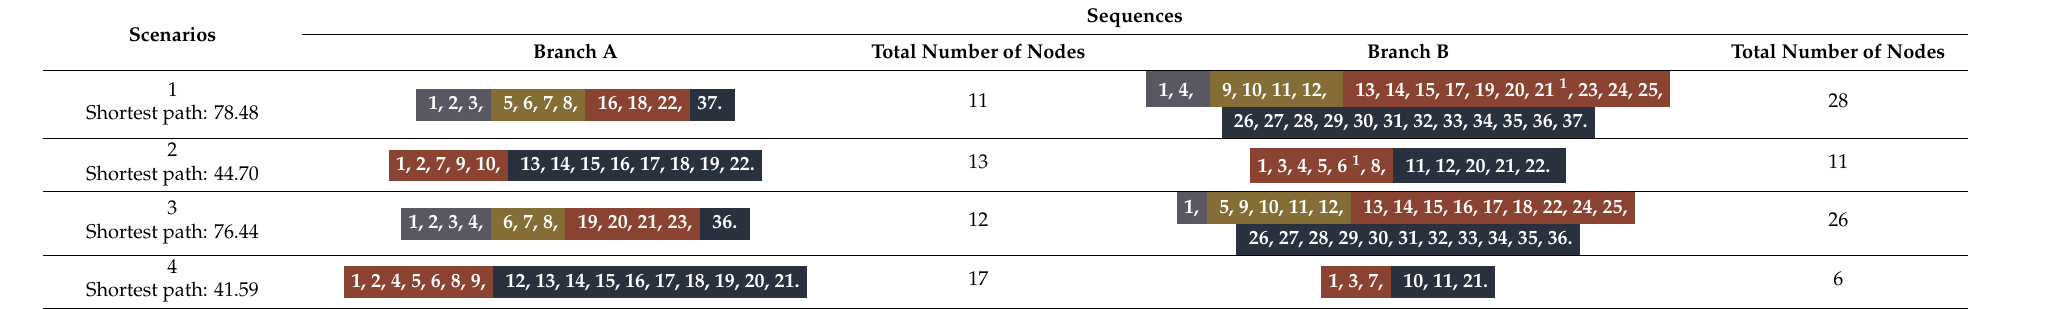
Table 5. Summary of the main results obtained from the application of the scheduling task optimization method to several established scenarios. (Legend: (cid:4) Operations from the reception of the grapes to the beginning of fermentation; (cid:4) Operations related to fermentation control, must be preparation, clarification, transfer, and pressing; (cid:4) Winemaking operations, including the processes of fortification (liquor wines), clarification, stabilization, filtration, ageing, and blending; (cid:4) Operations related to the reception of packaging materials, bottling, boxing, palletizing, storage, and